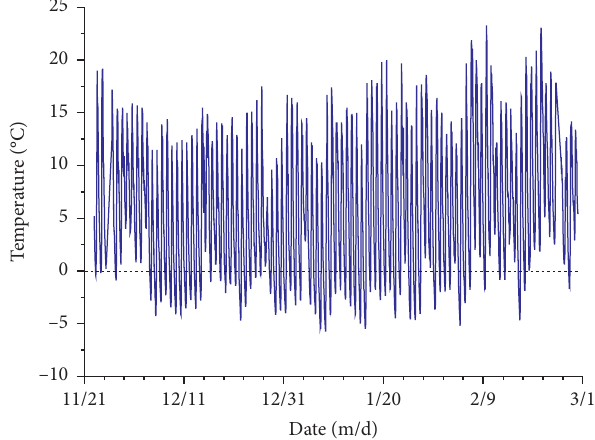
Figure 2: Variation of air temperature of the dam core wall